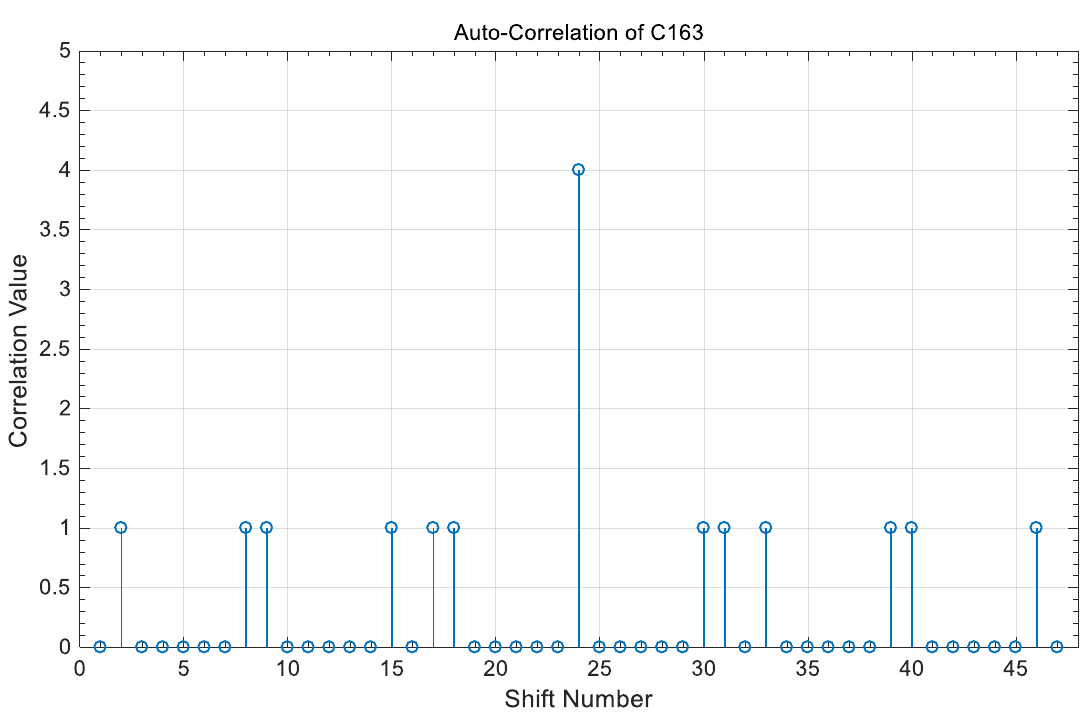
Figure 6. Auto-correlation of C 163 sequence, P 1 = 5 and P 2 = 7.